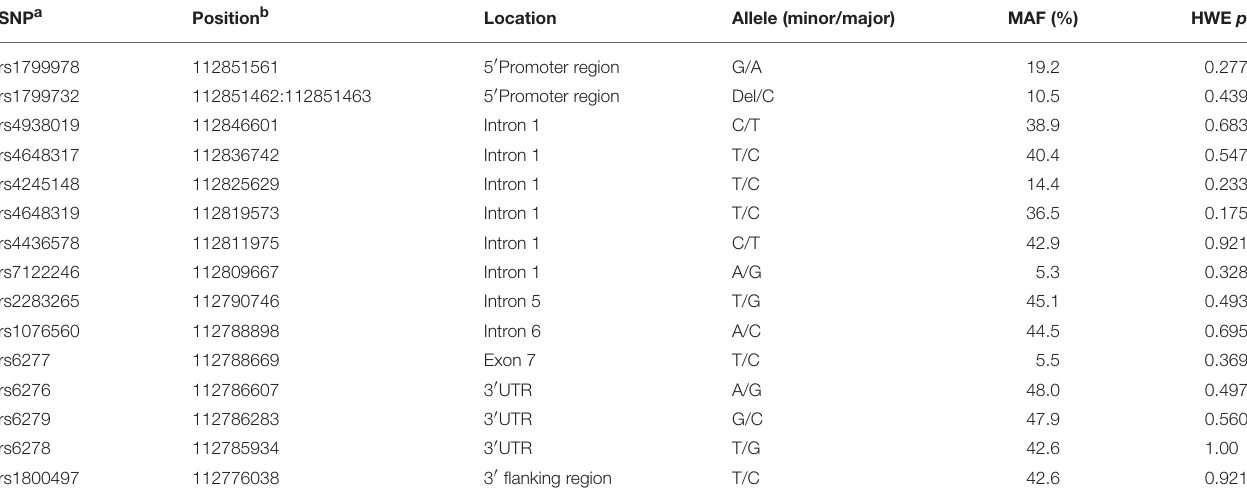
TABLE 1 | Characteristics of the Genotyped